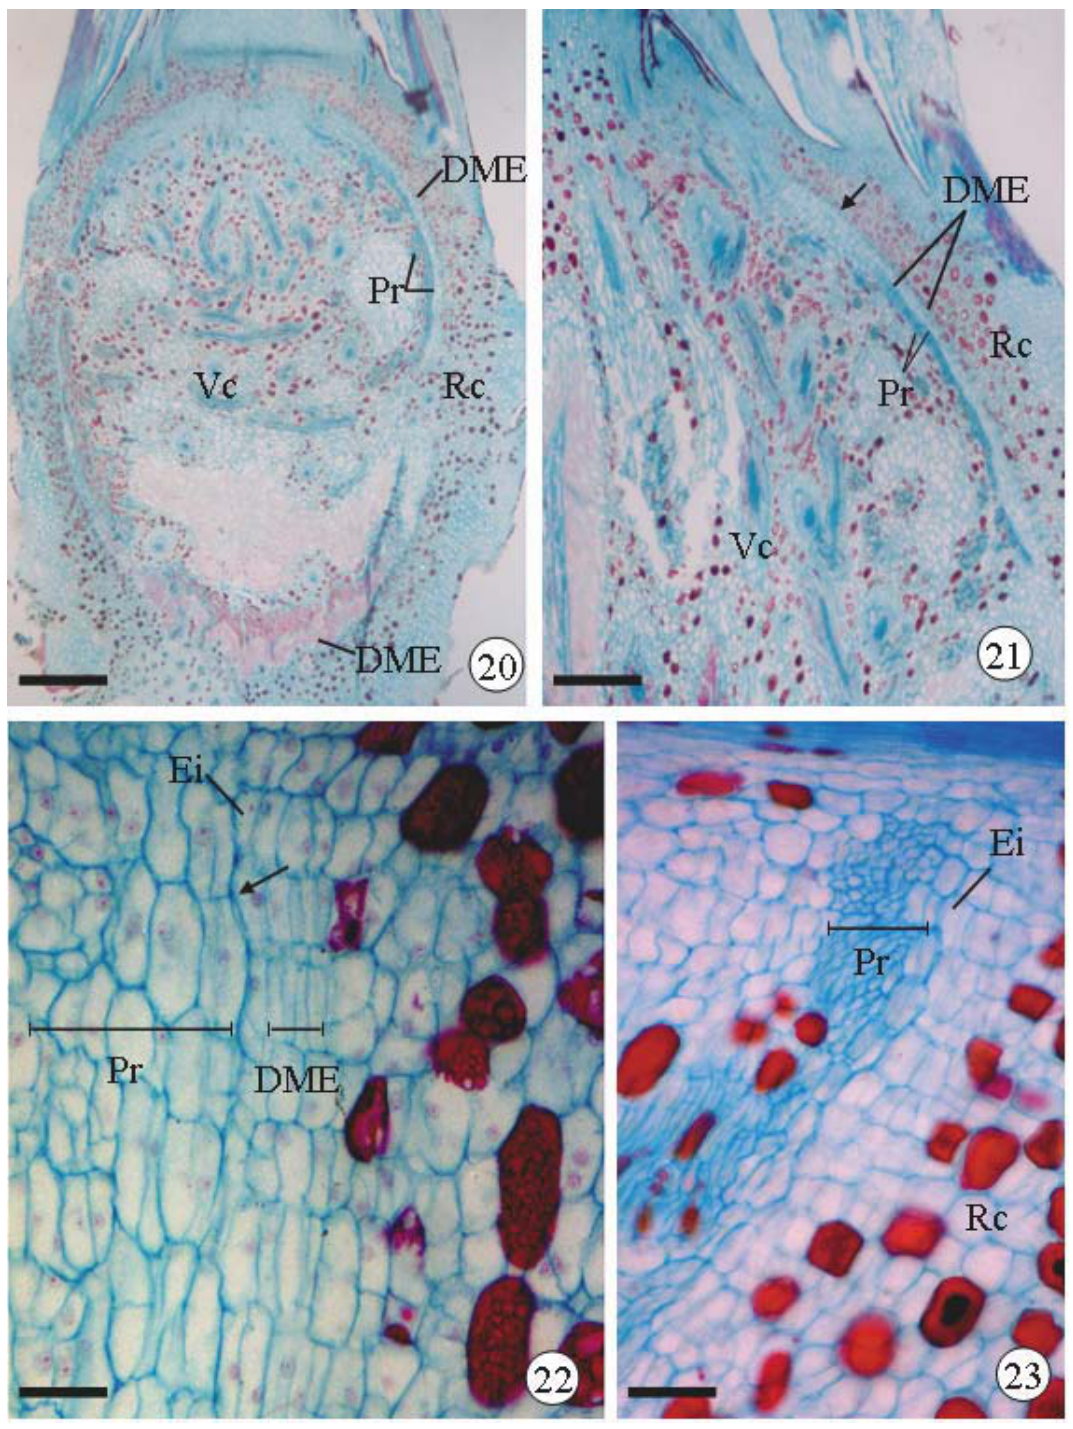
Fig. 20-23 – Lagenocarpus rigidus . Longitudinal sections of the rhizome. Note in Fig. 20 and 21 a distinct separation between the pericycle (Pr), which is the generating layer of vascular tissue, and the derivative layers of the meristematic endodermis (DME). In Fig. 21 the arrow indicates the region represented in Fig. 22. In Fig. 22, the arrow indicates the wall that separates the pericycle in its meristematic phase, from the endodermal initial (Ei), this being slightly more thickened. Note a gap between the outermost layers of the pericycle and the endodermal initials. Rc – rhizome córtex; Vc – vascular cylinder. The bars correspond respectively to: 600 µ m, 400 µ m, 50 µ m and 100 µ